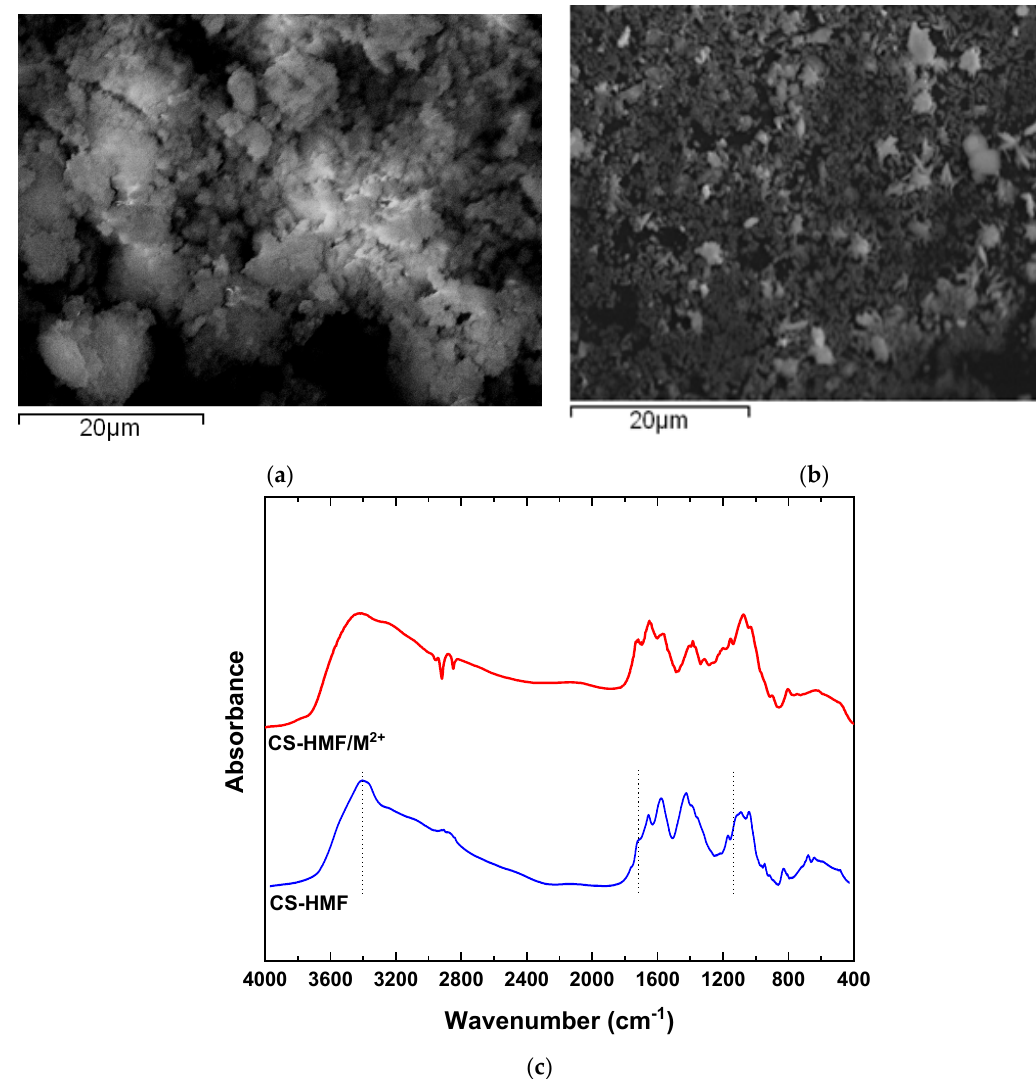
Figure 1. ( a ) SEM images of chitosan natural polymer 5-hydroxymethyl-furfural (CS-HMF) before metal ion removal; ( b ) SEM images of CS-HMF after metal ion removal (multi-component); ( c ) FTIR spectra of CS-HMF before and after metal ion removal.